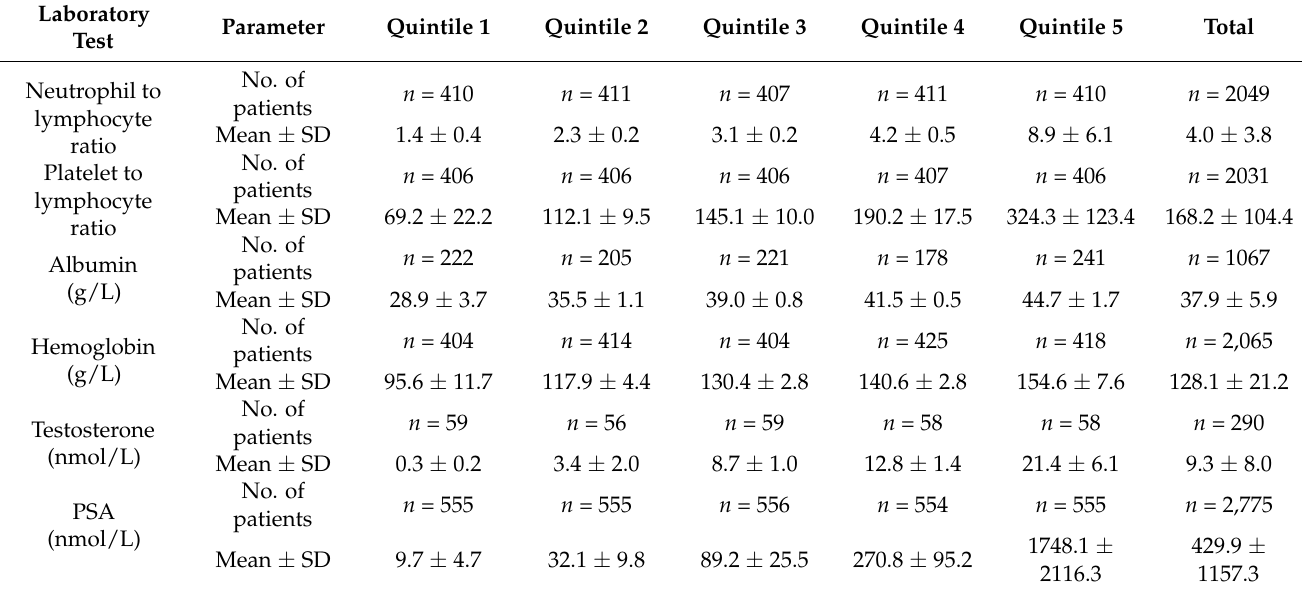
(Table A4). For exploratory analysis, no significant associations were observed between the exposure variables and the time to castrate resistance. Table 2. Quintile values of laboratory tests (exposure variables).